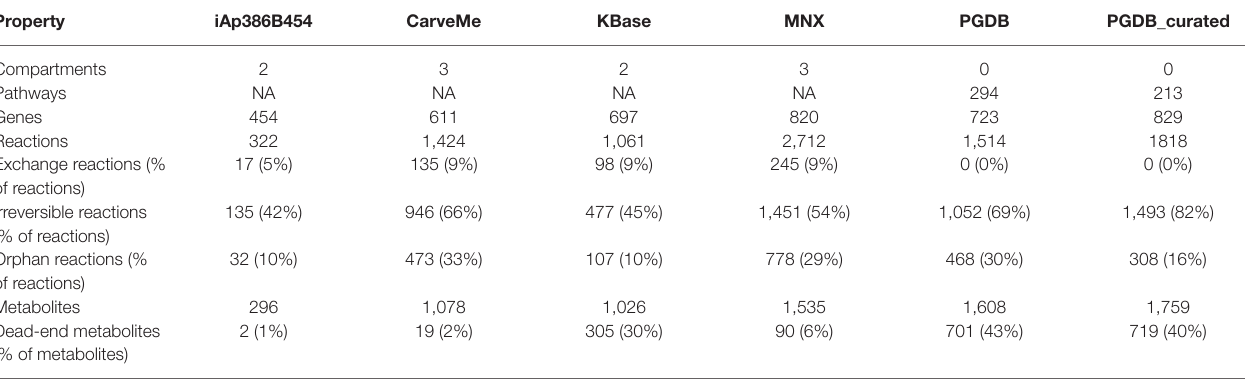
TABLE 2 | Properties of currently available reconstructed genome-scale metabolic models of A. pasteurianus 386B.